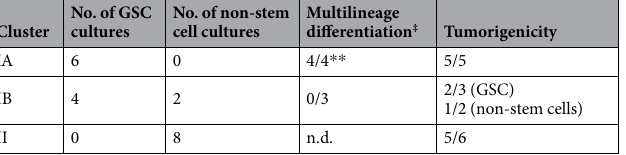
Table 2. Characteristics of the clusters identified based on the 51 most differentially expressed miRNAs. ‡ Number of cell cultures exhibiting pronounced differentiation in serum containing media/number of analyzed cell cultures, ** P < 0.05, Pearson’s chi-squared test compared to cluster IB, n.d. - not